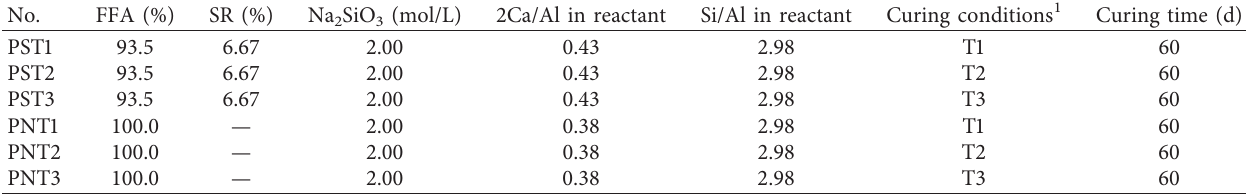
Table 4: The designed mixing proportions and curing conditions for the AAFCs.